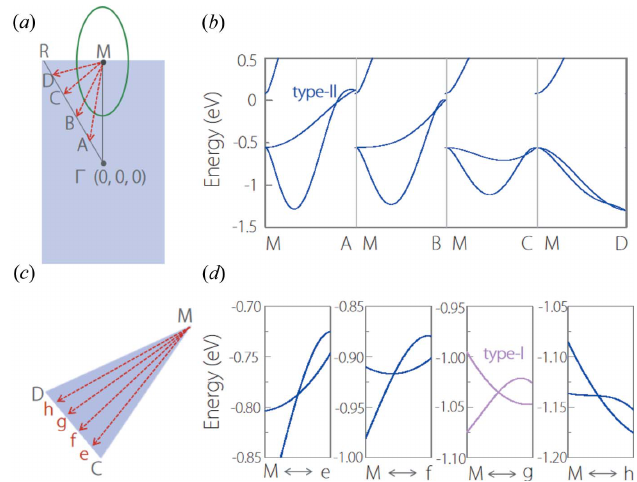
Figure 11 ( a ) Schematic illustration of the nodal line centering on the M point in the